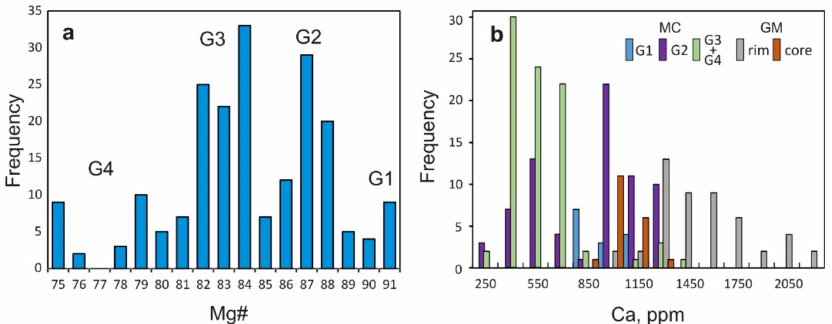
Figure 3. Histogram of Mg# ( a ) and Ca ( b ) contents in olivines. MC—compositions of macrocrysts: ( G1 ) —high-Mg core, ( G2 )—core having Mg# similar to that of groundmass olivines, ( G3 ) —core with low Mg#, ( G4 )—core with anomalously low Mg#; GM—groundmass olivines: rim—composition of rims, core—composition of the central part. Mg# = 100 × Mg/(Fe +